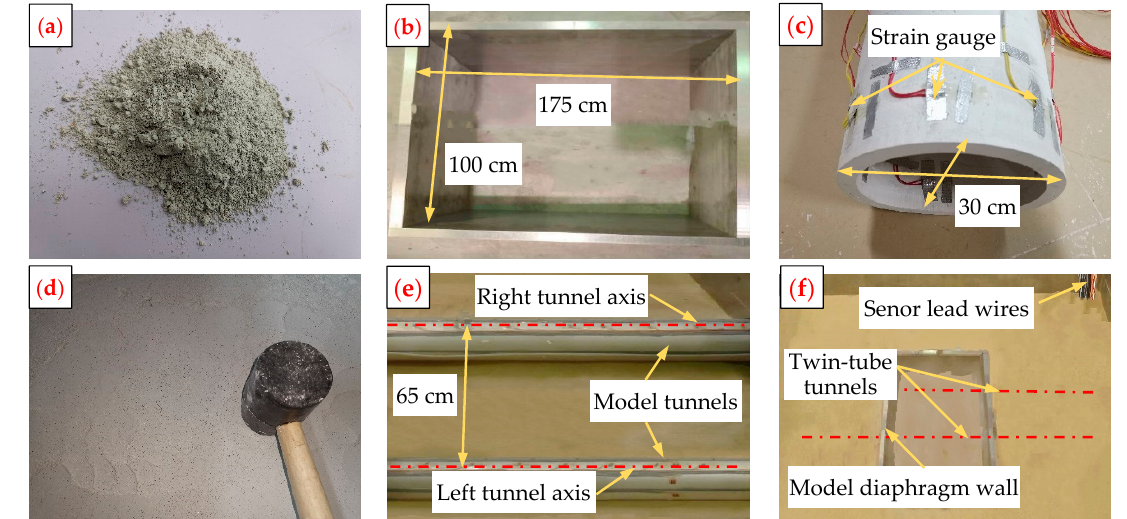
Figure 3. Layout and geometry of the model.